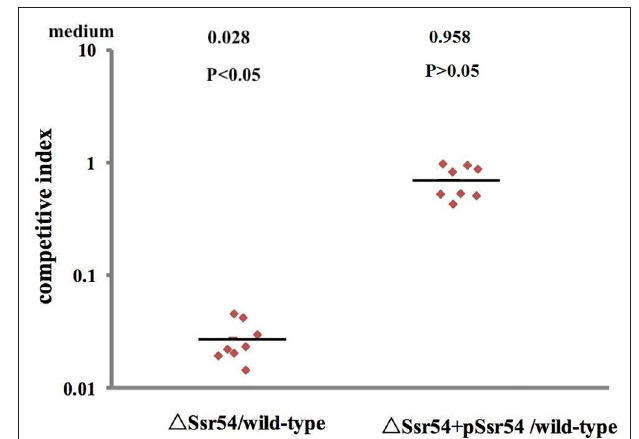
FIGURE 6 | Mit4ce were infected with wild-type, mutant 1 Ssr54 , and complement strains. A competitive index (CI) of 1 represents recovery of equivalent amounts of wild-type and mutant bacteria. The CI of the Ssr54 mutant and wild-type was lower than 1 ( P < 0.05); The CI of the Ssr54 complement strain and wild-type was ∼ 1 ( P >